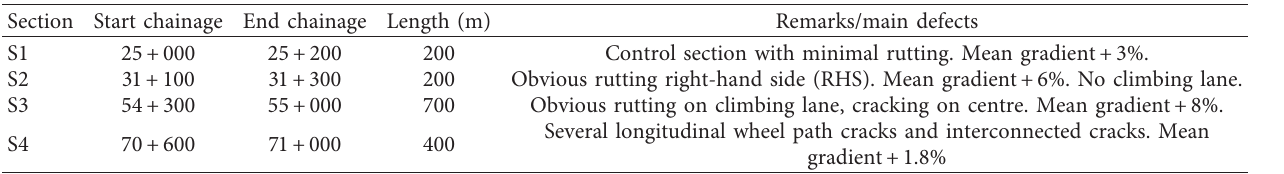
Table 4: Detailed sections selected on the road.